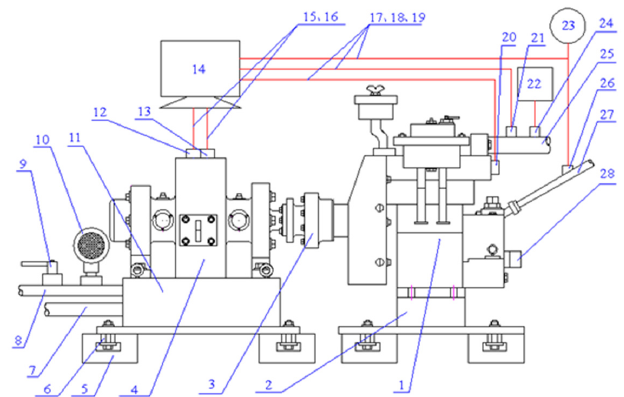
Figure 3. Diagrammatic sketch of the test bench of swirl chamber diesel engine. (1) Diesel engine, (2) diesel engine base, (3) coupling, (4) eddy current dynamometer, (5) guide rail, (6) bolt, (7) drainage pipe, (8) intake pipe, (9) water valve, (10) water pressure gauge, (11) dynamometer base, (12) torque sensor, (13) speed sensor, (14) FC200 measurement and control platform, (15) torsion signal